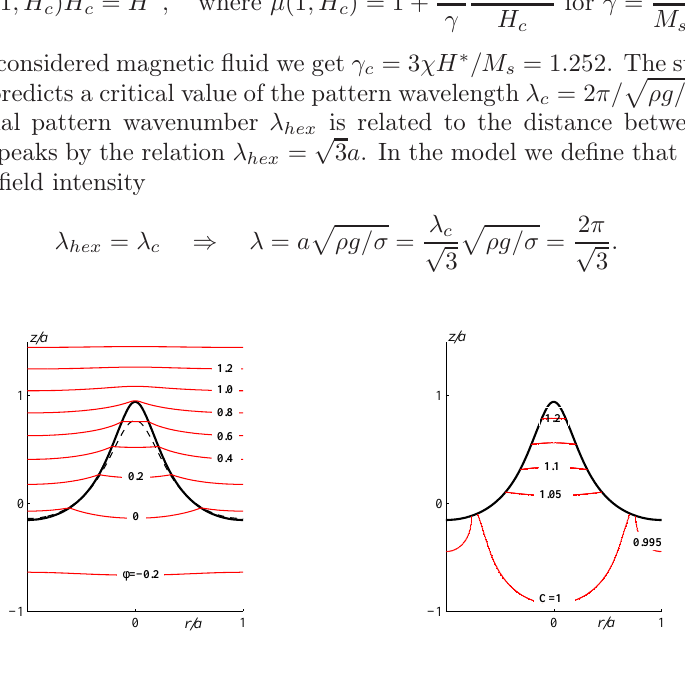
Figure 2. Overcritical free-surface shapes, isolines of the dimensionless potential (left) and of the dimensionless concentration (right) at the applied field intensity γ = 1 . 265 . Solid (dashed) shape-lines corresponds to the non-uniform (uniform) particle